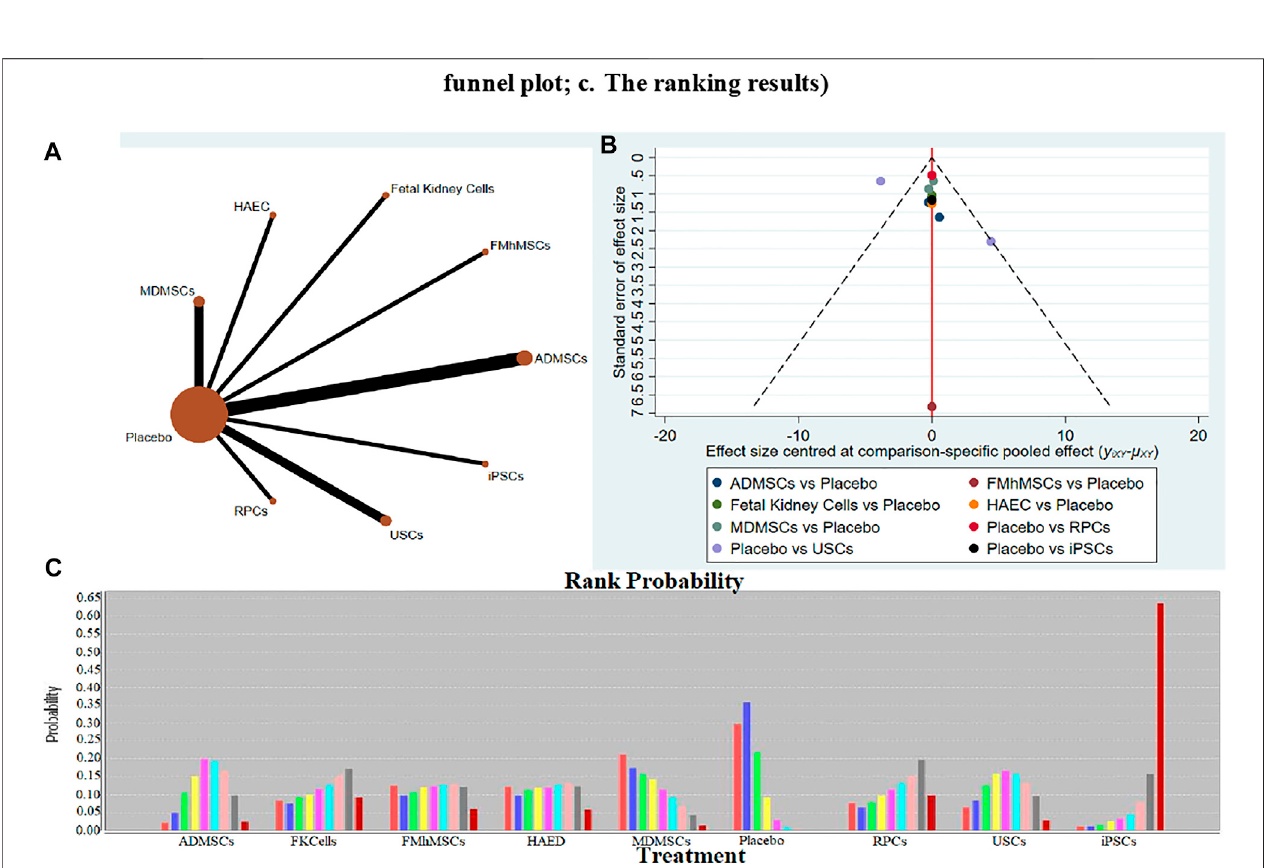
FIGURE 11 | Network Meta-analysis of apoptosis of resident cells in stem cell group and negative control group in early stage after administration (A) Evidence network diagram; (B) The comparison-correction funnel plot; (C) The ranking results).